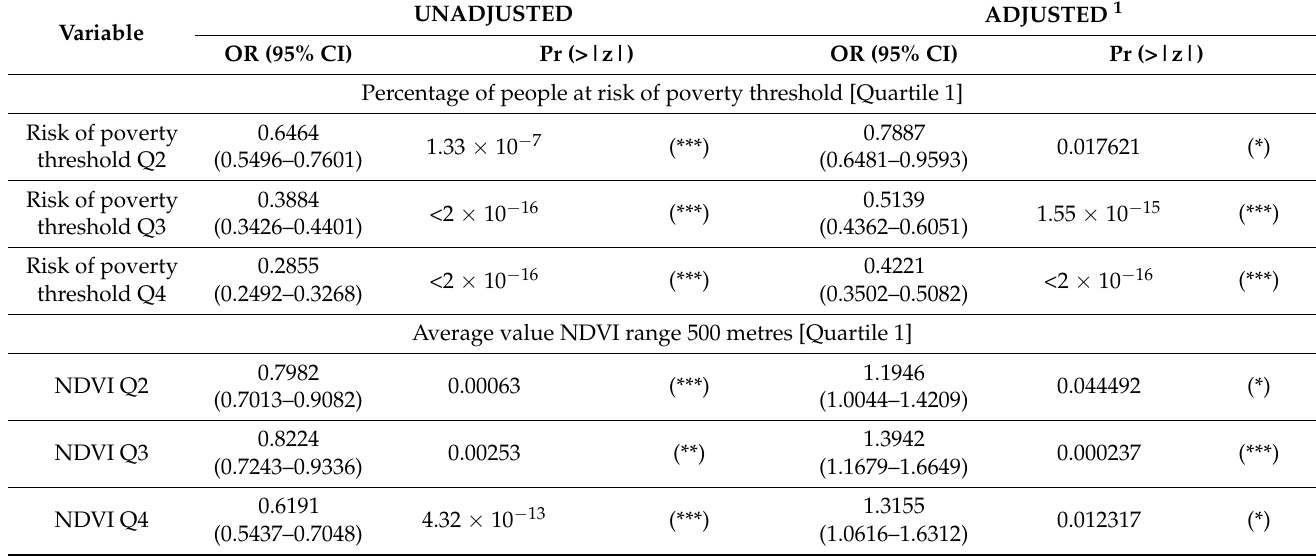
Table 3. Association between air pollutants and socioeconomic variables with the possibility of not renting a home for a family at risk of social